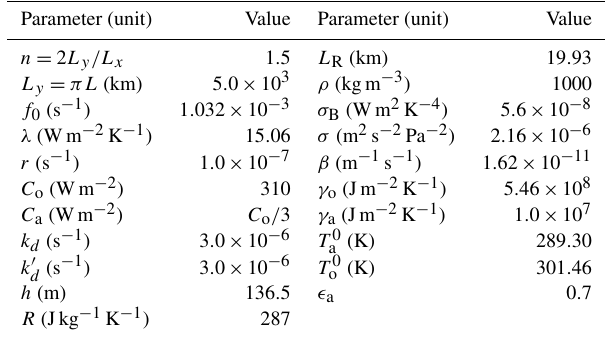
Table 3. Model parameter values that are identical across all MAOOAM configurations used in this